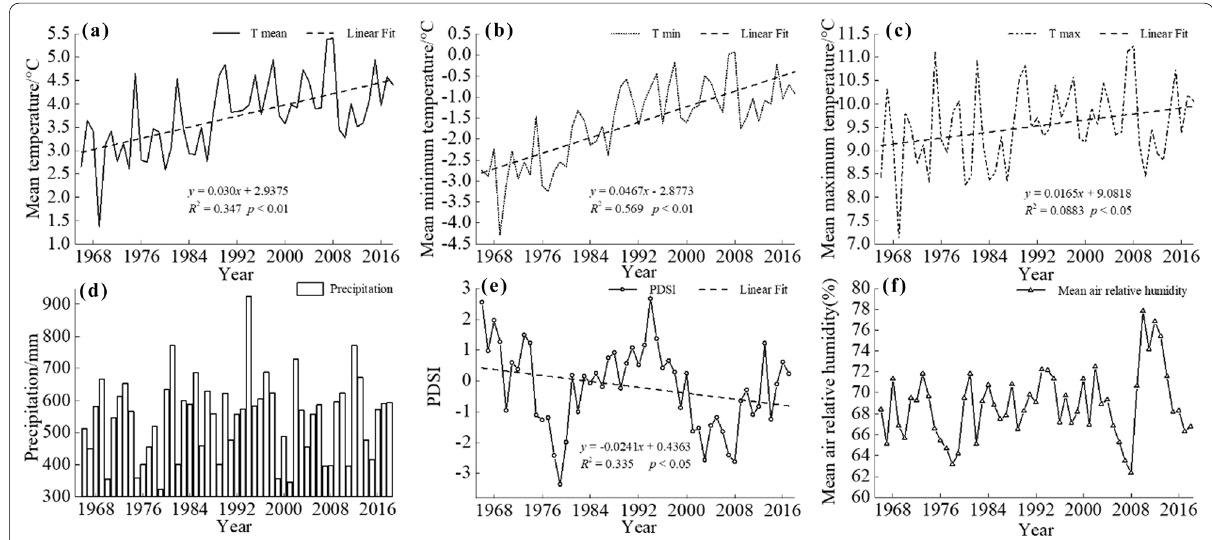
Fig. 5 Climatic interannual changing trend in the study area during the period of 1966–2018. a Mean temperature, b mean minimum temperature, c mean maximum temperature, d precipitation, e PDSI, and f air relative humidity. The dashed lines are indicative of the significant linear regression trends with the equations, p values, and R 2 values highlighted